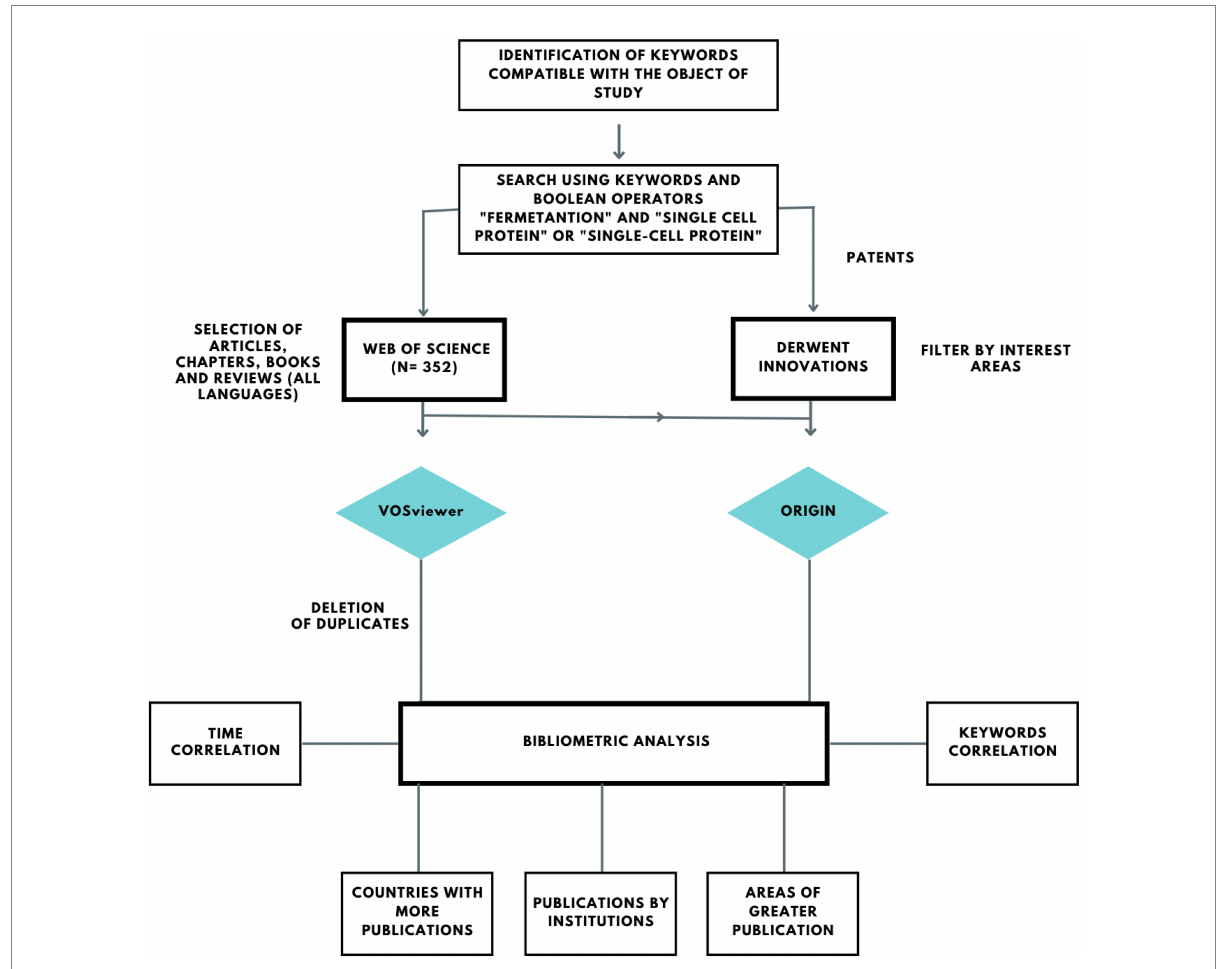
FIGURE 1 Methodological steps performed in the present study for the bibliometric search and